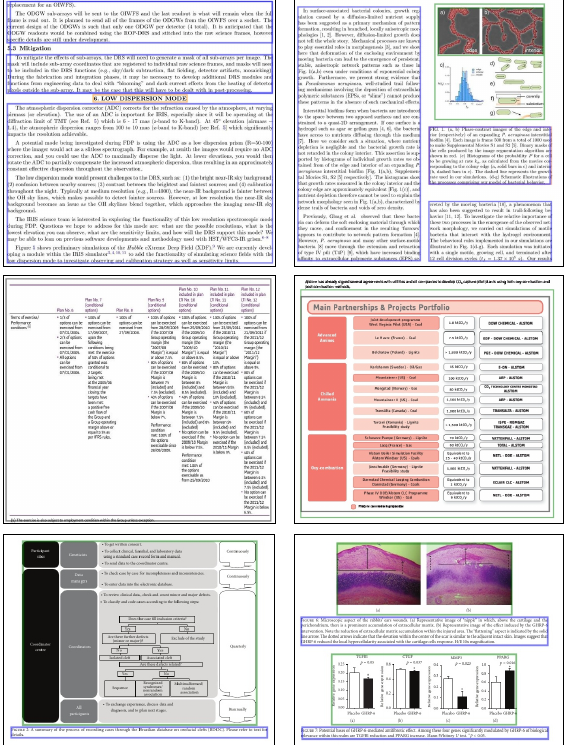
Figure 1. Visual representation of the detections obtained by the proposed model on publicly available benchmark datasets, i.e., DocBank [19], PublayNet [20], and IIIT-AR-13K [21]. Colors are used as visual embeddings to distinguish various detected objects. Blue, orange, green, and black represent paragraphs, title, figures, and tables, respectively. The first, second, and third rows represent samples from DocBank, IIIT-AR-13K, and PublayNet,